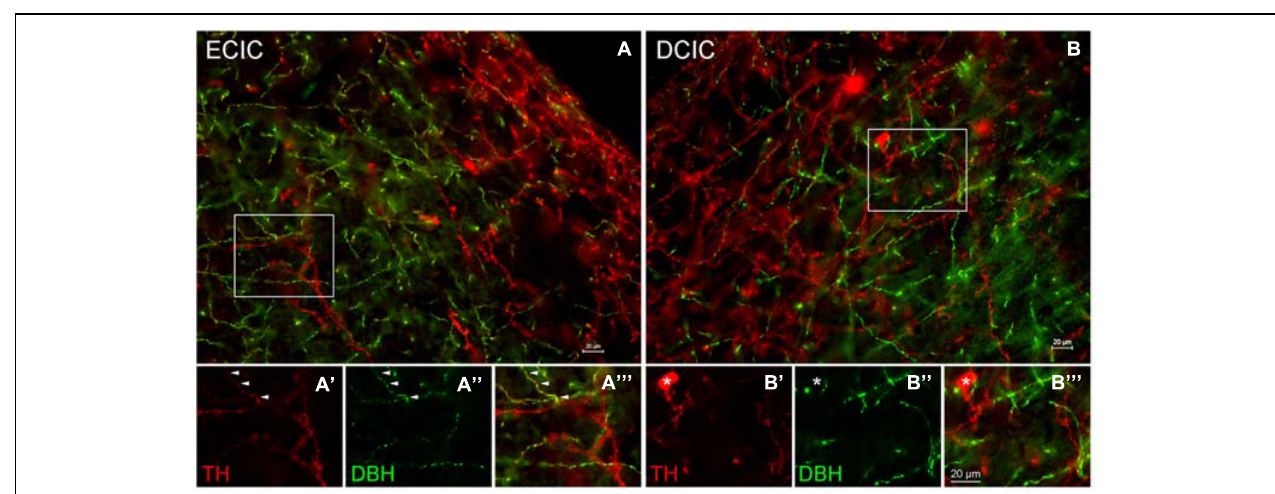
ECIC labeling for TH is predominant (A) . In the dorsal cortex of the IC (DCIC) labeling for TH and DBH was observed throughout the subdivision (B) . There were somata, fibers and terminals that labeled only for TH (red), some fibers that labeled for both TH and DBH (yellow) and a population of fibers that appeared to label only for DBH (B’–B”’) . Asterisk: somata labeled only for TH Scale bar: 20 μ